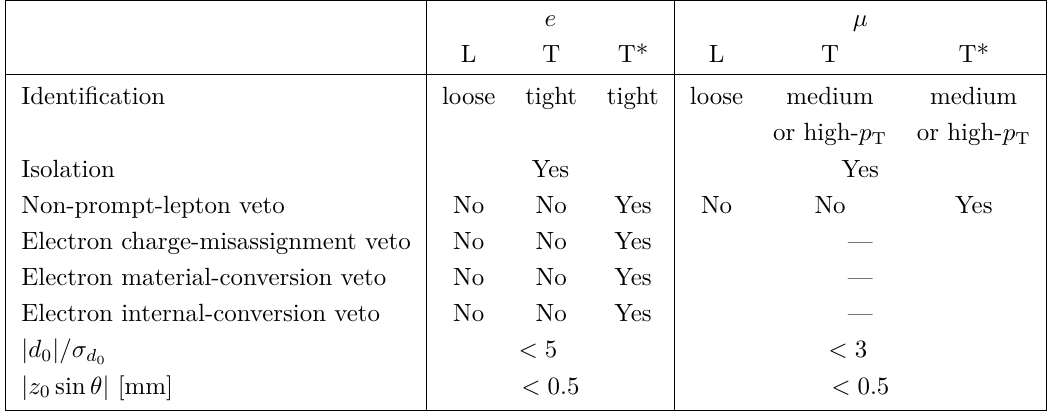
Table 2. Summary of requirements applied to define Loose (L), Tight (T), and Very Tight (T*) light leptons. The quality cuts for tight muon identification depend on the transverse momentum of the muon